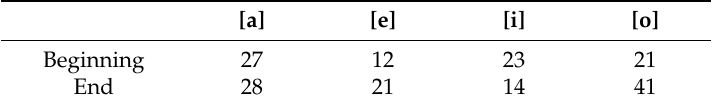
Table A3. Token counts for vowel formant measurements used to assess changes in individual vowel production by Informant A in Section 4.2.1.